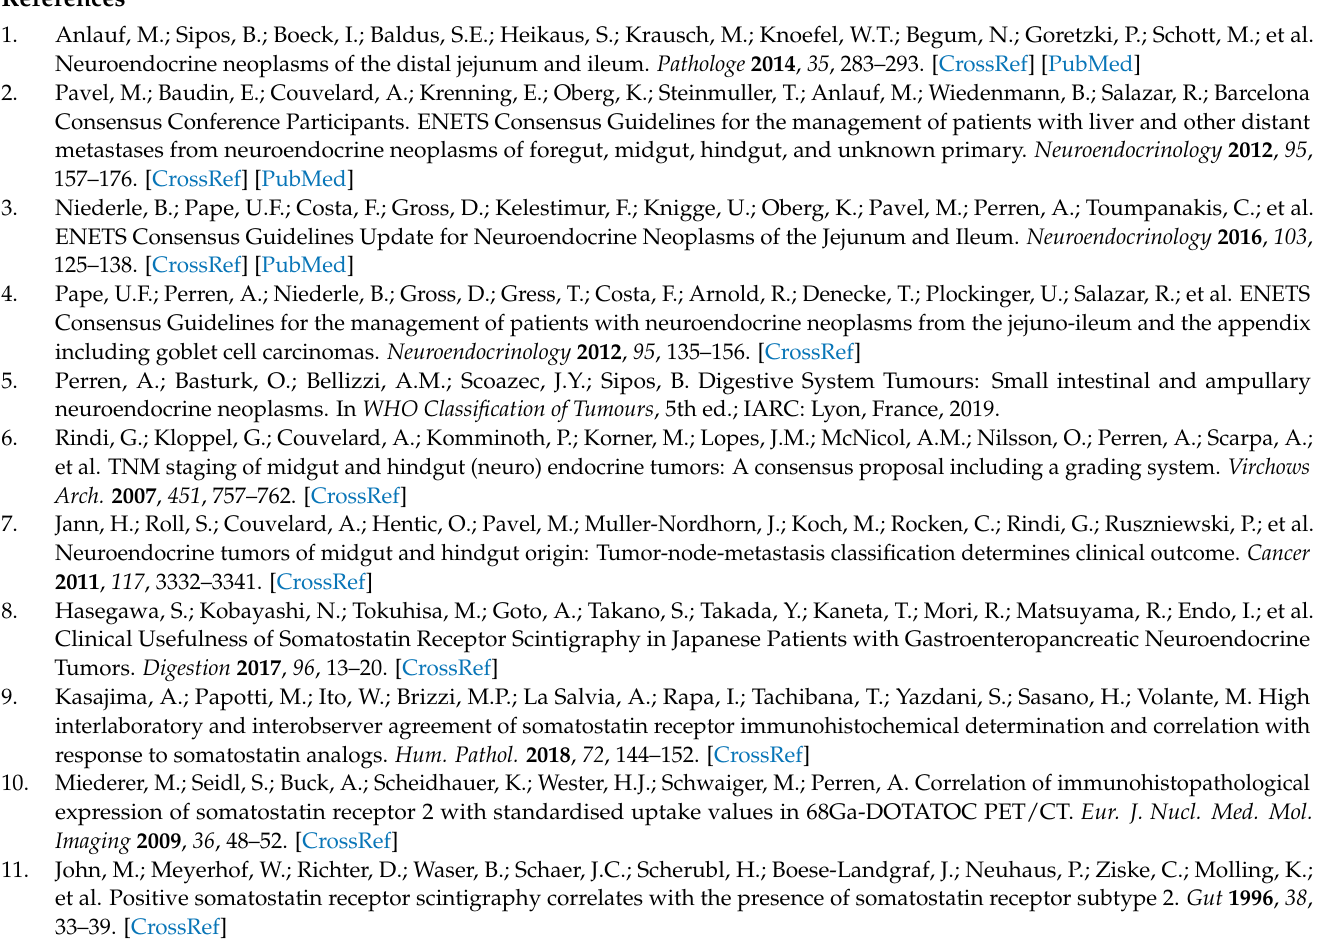
Table S2: Clinicopathological characteristics of the unifocal SI-NET control